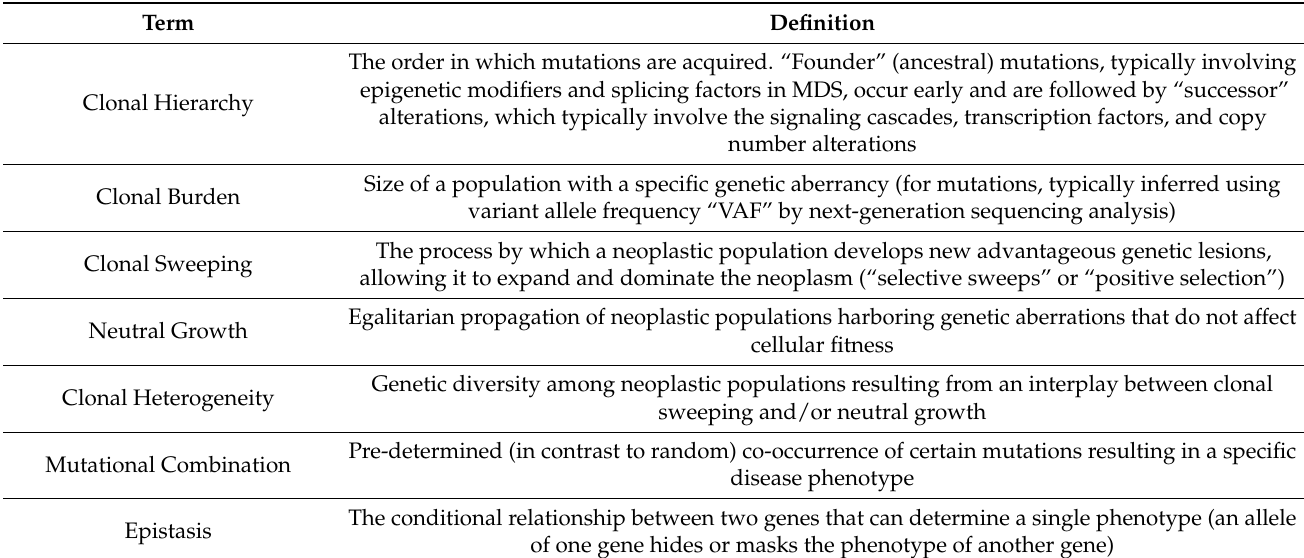
Table 1. Glossary of major concepts pertaining to clonal evolution in myelodysplastic